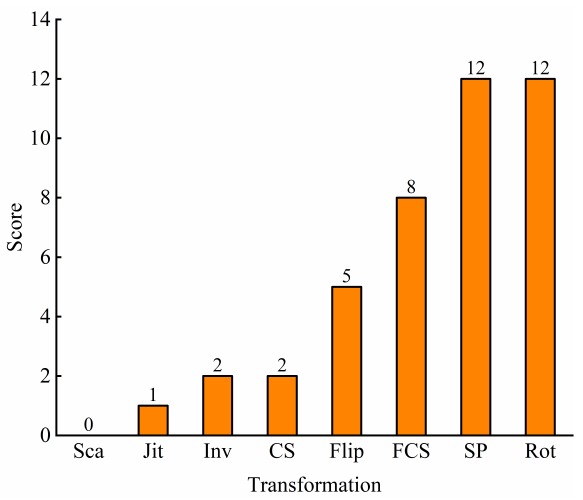
Figure 8. Score for individual